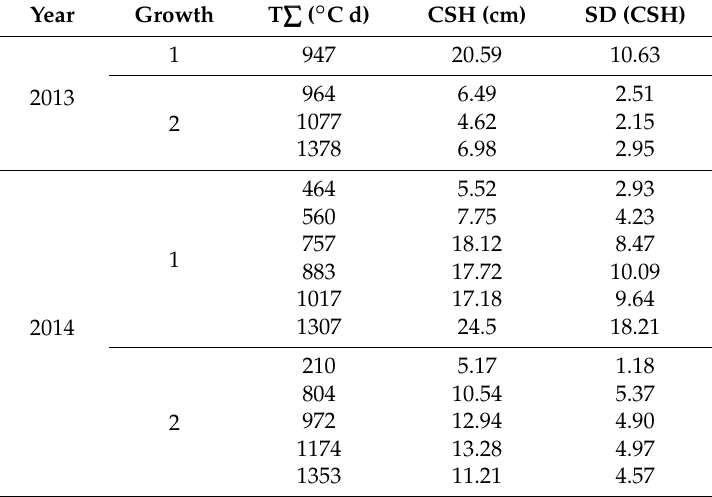
Table A2. Averages and standard deviations of the Compressed Sward Height (CSH) measurements for 2013 and